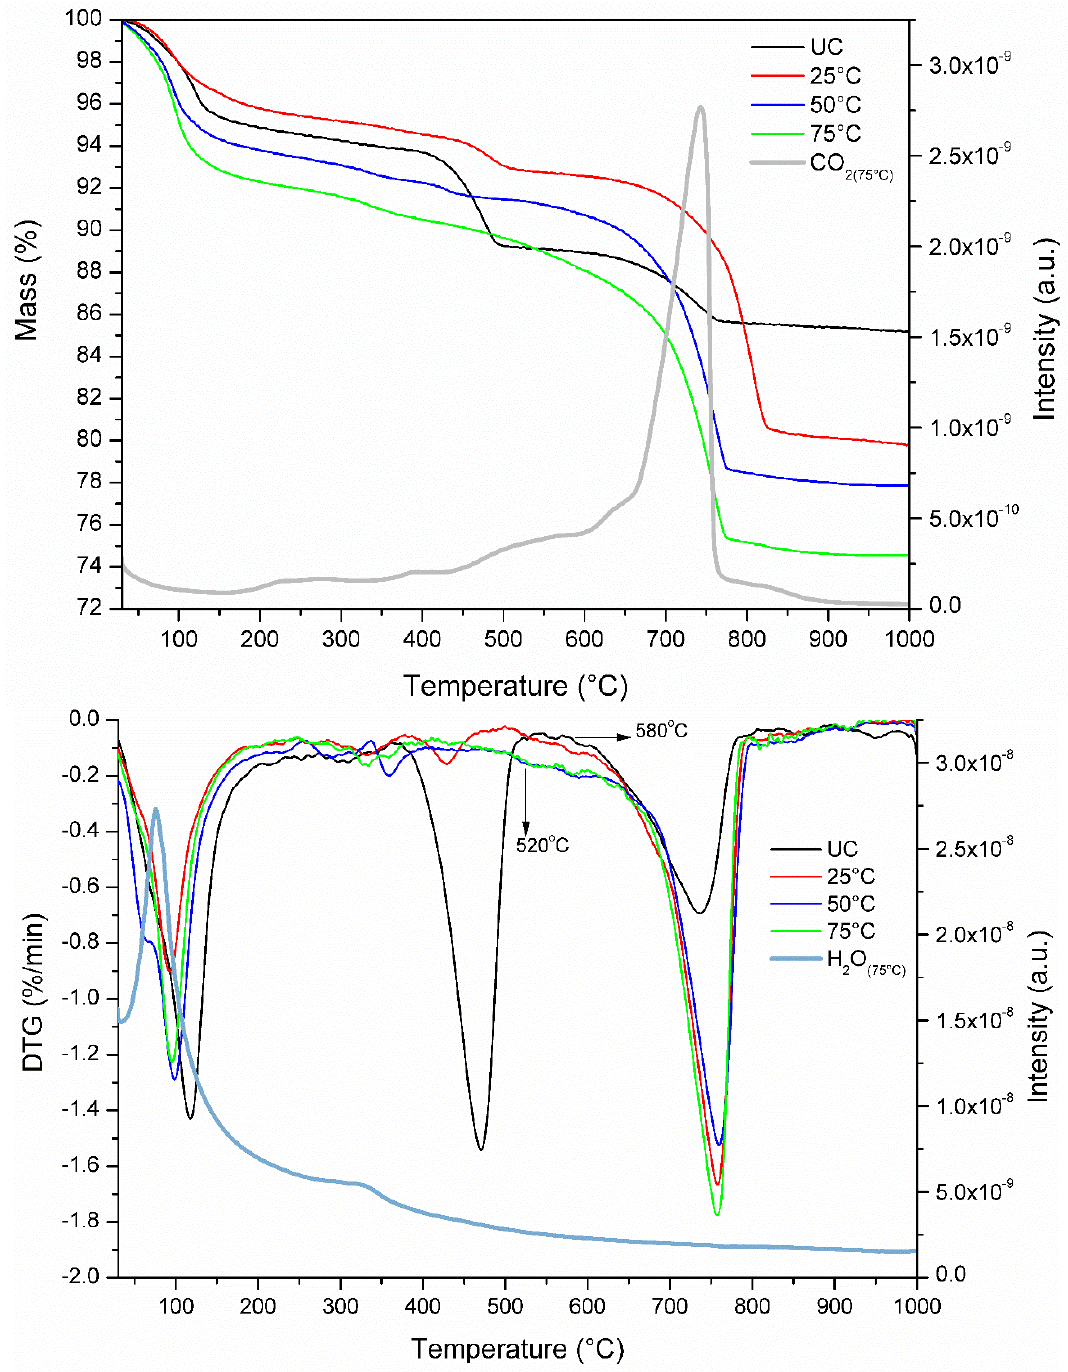
Figure 13. TGA and DTG with MS (75 °C) of OSA compacts that are uncarbonated (UC) and cured at 25 °C, 50 °C, and 75 °C.